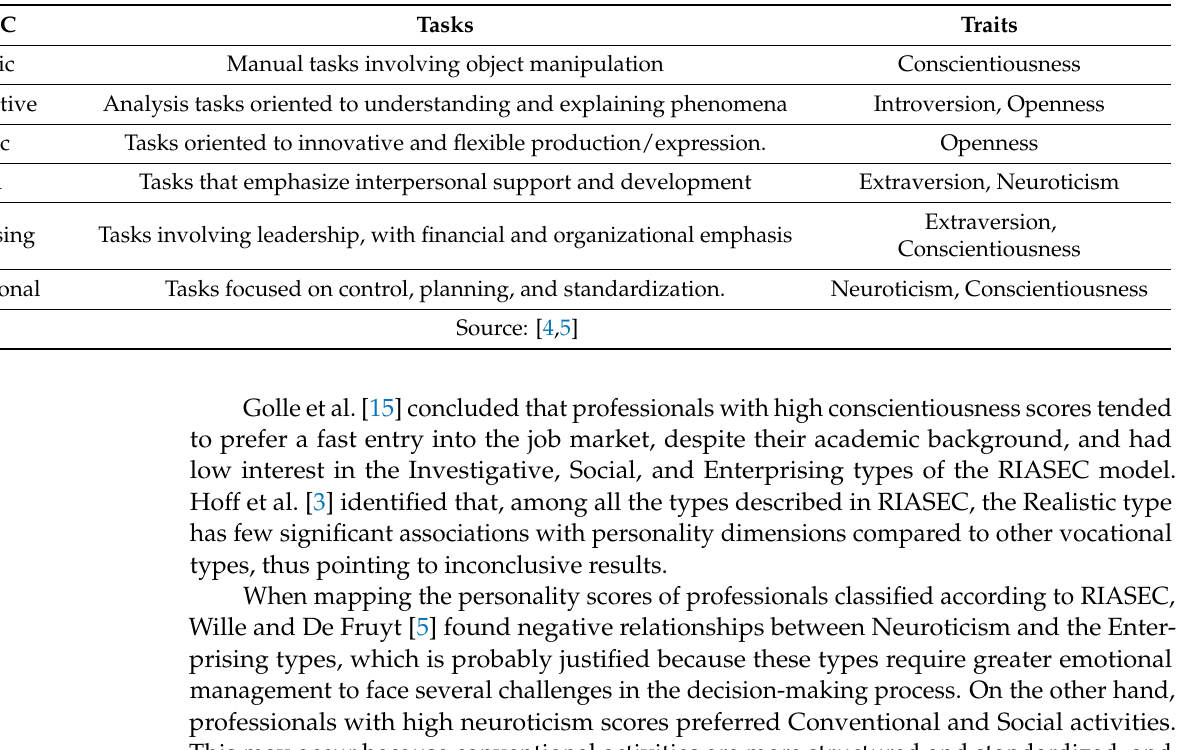
Table 1. Brief description of Personality Tasks and Characteristics in the RIASEC Model. RIASEC Tasks Realistic Analysis tasks oriented to understanding and explaining phenomena Artistic Tasks oriented to innovative and flexible production/expression.